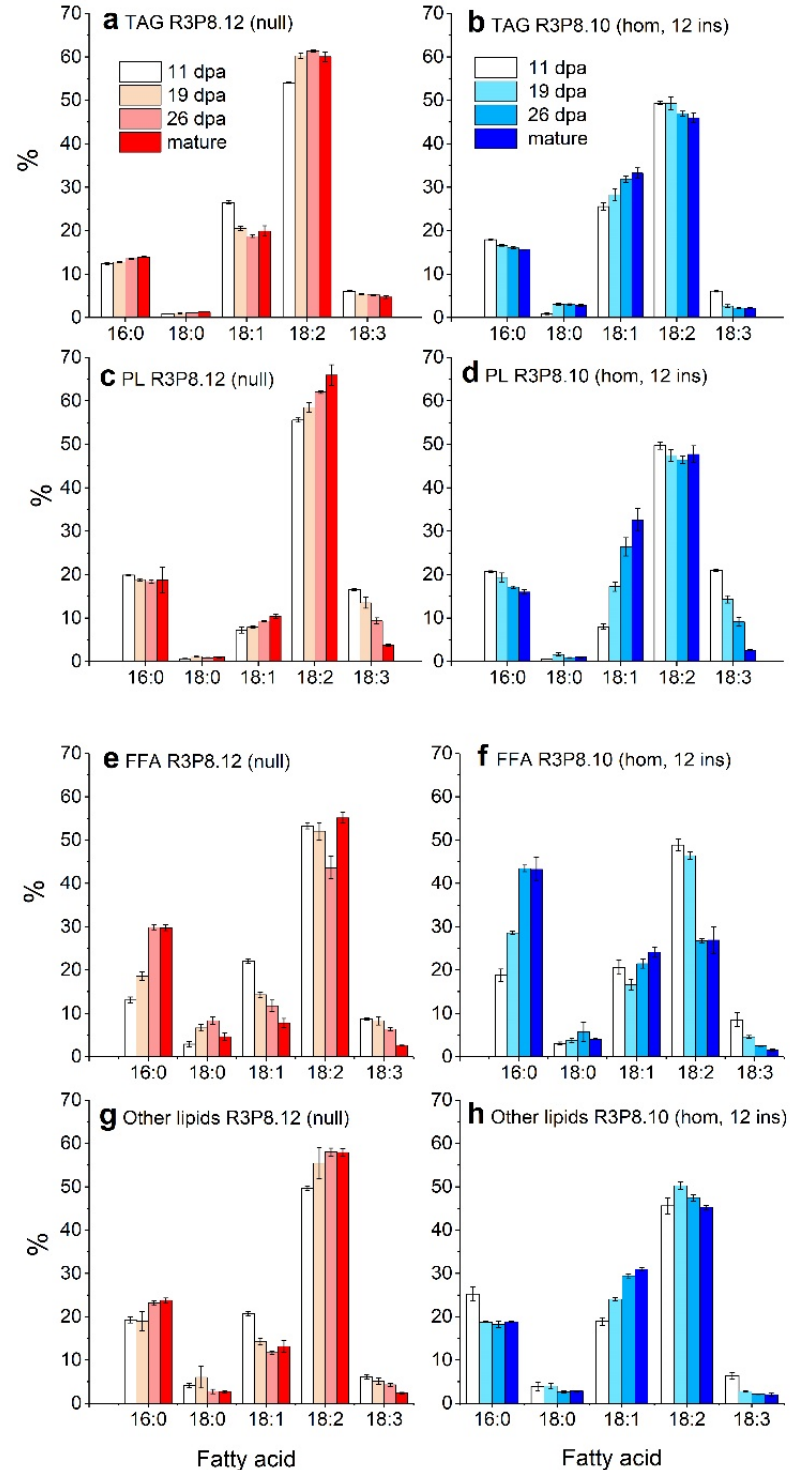
Figure 4. Fatty acid profiles of different lipid classes in the endosperm of developing caryopses from field grown AsWRI1 -wheat (line R3P8.12, null (control) and line R3P8.10, homozygous with 12 gene inserts). ( a , b ) triacylglycerol (TAG), ( c , d ) polar lipids (PL), ( e , f ) free fatty acids (FFA), ( g , h ) other lipids. Profiles are given as percentage by weight of total major fatty acids (16:0 (palmitic acid), 18:0 (stearic acid), 18:1 (oleic acid), 18:2 (linoleic acid), and 18:3 (linolenic acid)) at 11-, 19-, and 26-days post anthesis (dpa) and at seed maturity. Results are mean values of three replicates (i.e., field plots) ± standard deviation.